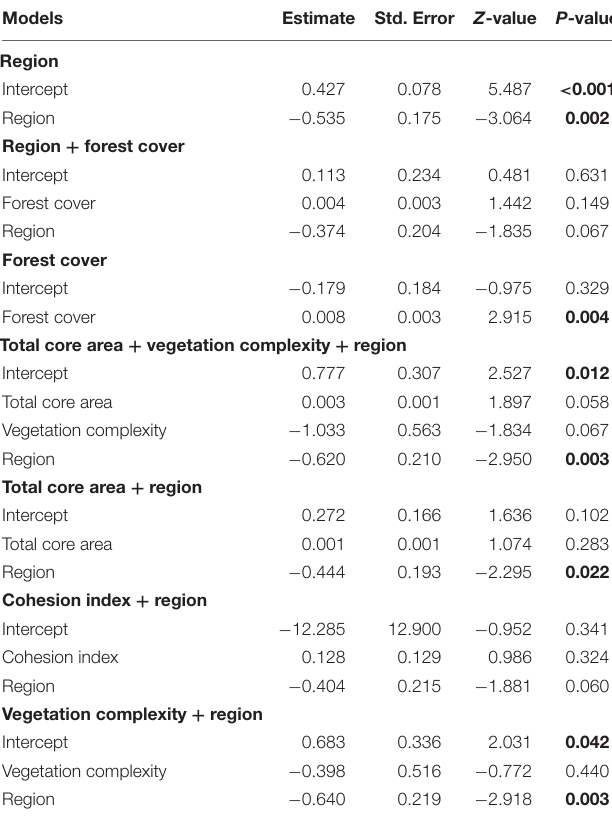
TABLE 2 | Results from General Linear Models testing for the effects of local and landscape predictors on the number of interactions in 19 bird-plant networks.